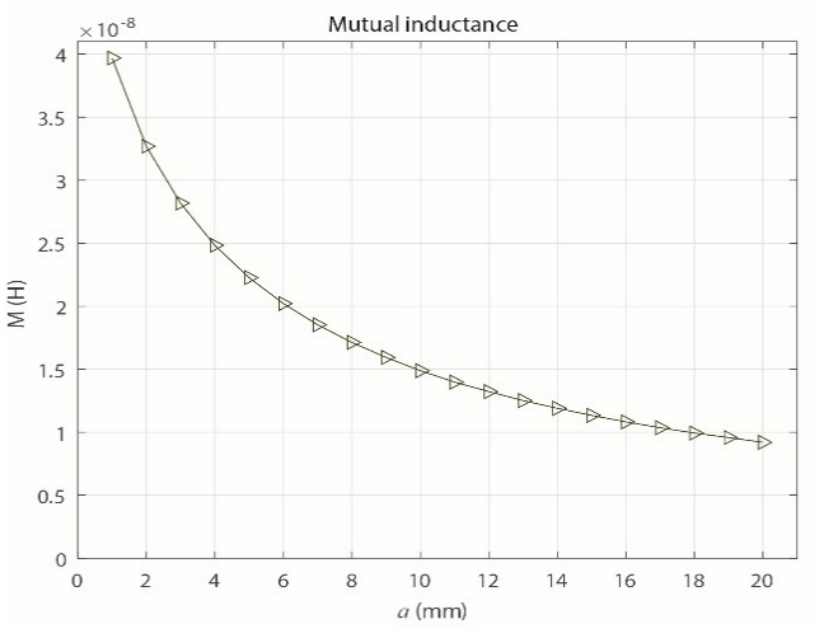
Figure 6. Mutual inductance obtained with FEMM with increasing a .